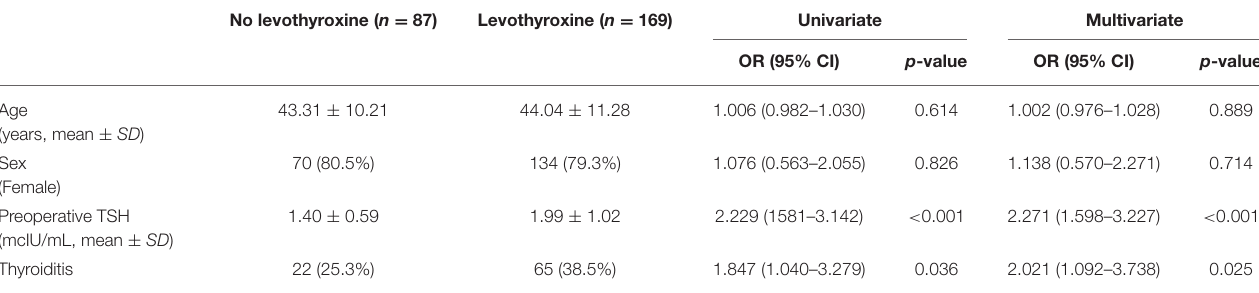
TABLE 3 | Univariate and multivariate analyses for clinical factors associated with levothyroxine